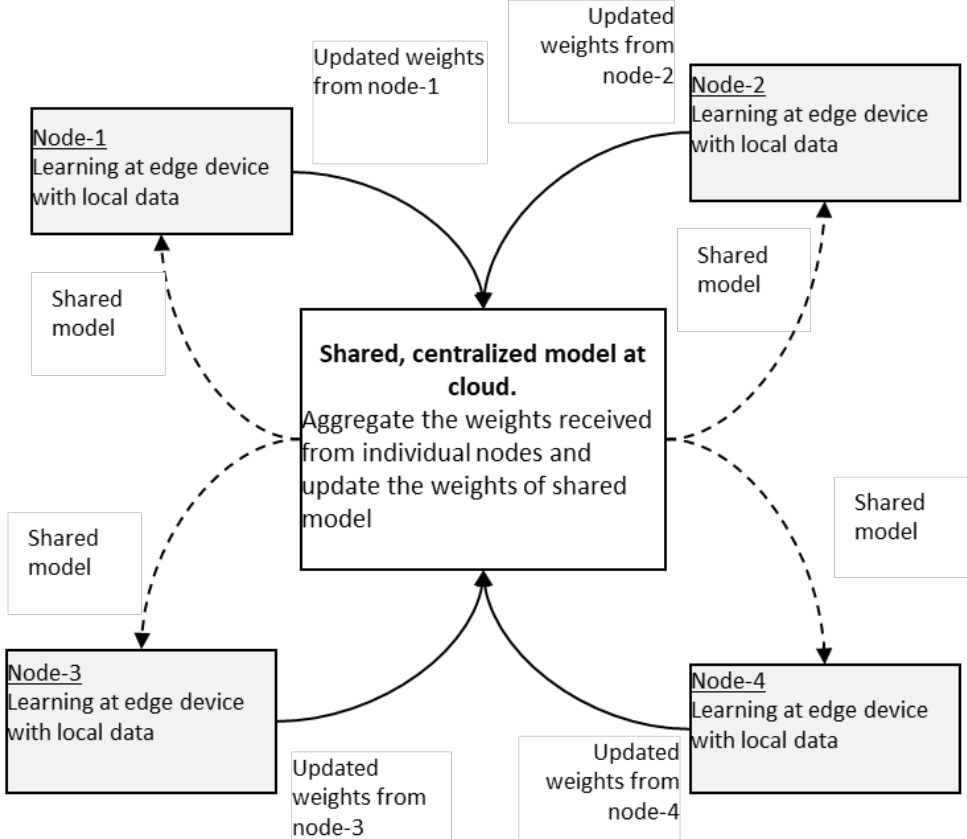
Figure 7. Concept of federated learning in edge servers (shown with four nodes). Federated learning is of two kinds, centralized [21] and decentralized (Figure 8).